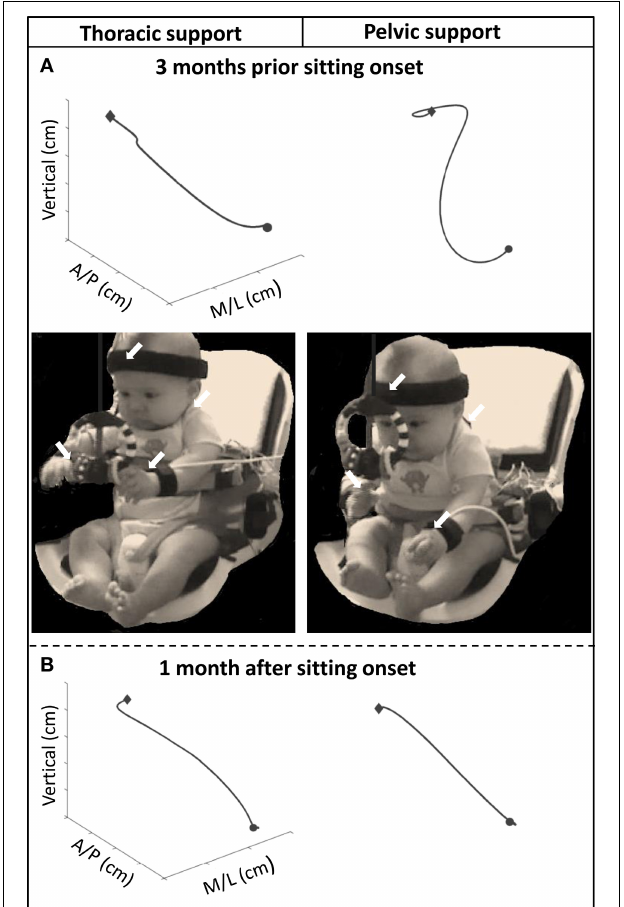
FIGURE 3 | Graphs above showing examples of the 3D trajectory of a single reach from onset (circular shape) to offset (diamond shape), of one infant with thoracic and pelvic support during (A) 3 months prior to sitting onset and (B) 1 month after sitting onset. Photographic images show infant reaching toward the toy with thoracic and pelvic support at 3 months prior to sitting onset. Arrows indicate location of kinematic sensors.